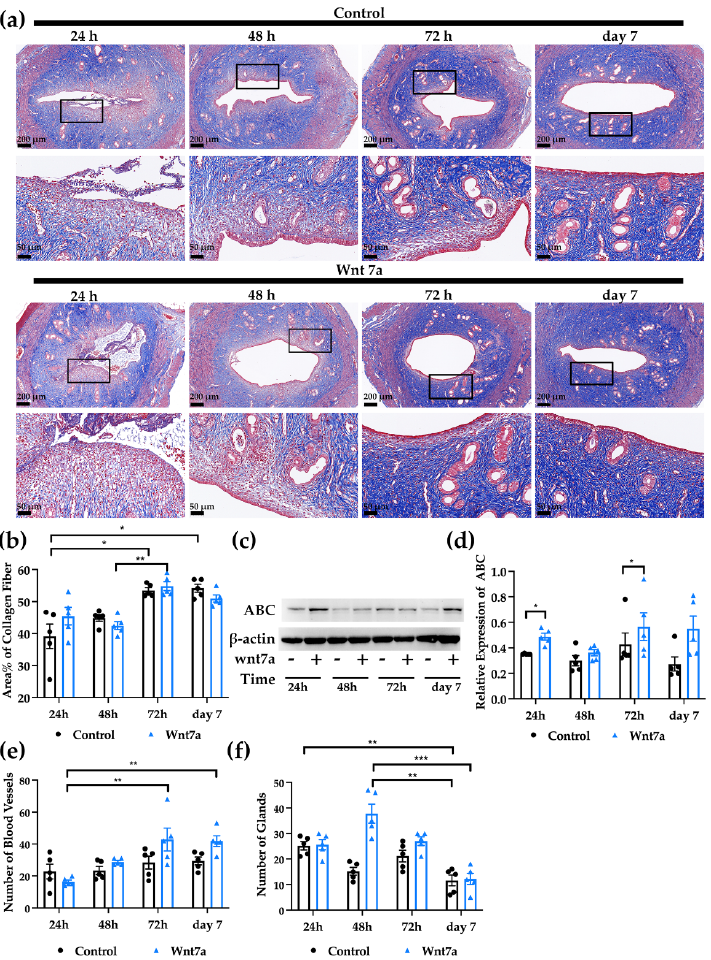
Figure 4. ( a ) Masson trichrome stained sections of rat uteri after induced injury with/without Wnt7a injection. Magnified areas are marked in black boxes. Scale bar, 200 µ m (top) and 50 µ m (bottom/magnified). ( b ) Area% of collagen fiber in the rat uteri is shown in bars. ( c ) Western blot analysis was performed to validate the activation of canonical Wnt signaling after injecting recombinant Wnt7a protein. ( d ) Relative quantification of ABC normalized to β -actin. Number of blood vessels ( e ) and glands ( f ) in the uteri per section at different times after the induced injury. Data are presented as mean ± SEM ( n = 5). * p < 0.05, ** p < 0.01, *** p <